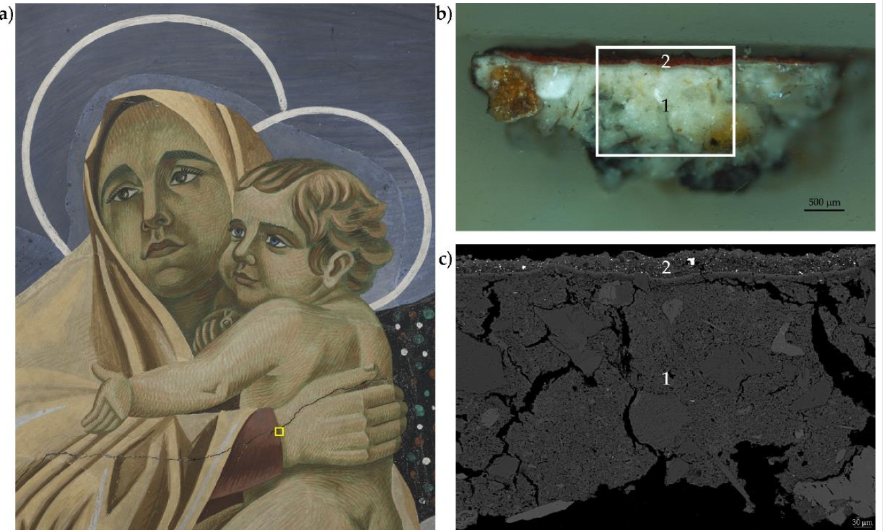
Figure 7. ( a ) Detail of the Virgin and Child (image size ca. 50 cm × 60 cm) with indication of the sampling area (yellow square); ( b ) optical microscope image and ( c ) SEM-BSE image of the cross- section of the micro-sample collected in ( a ). SEM-BSE image corresponds with the area indicated with a white rectangle in ( b